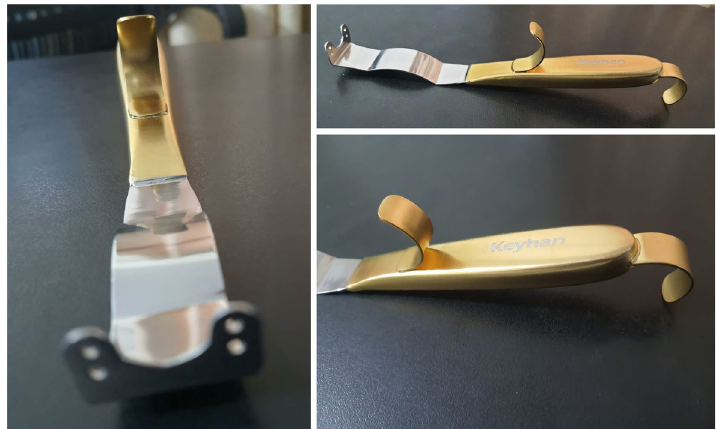
Fig. 2 Different views of Persian chin holder &